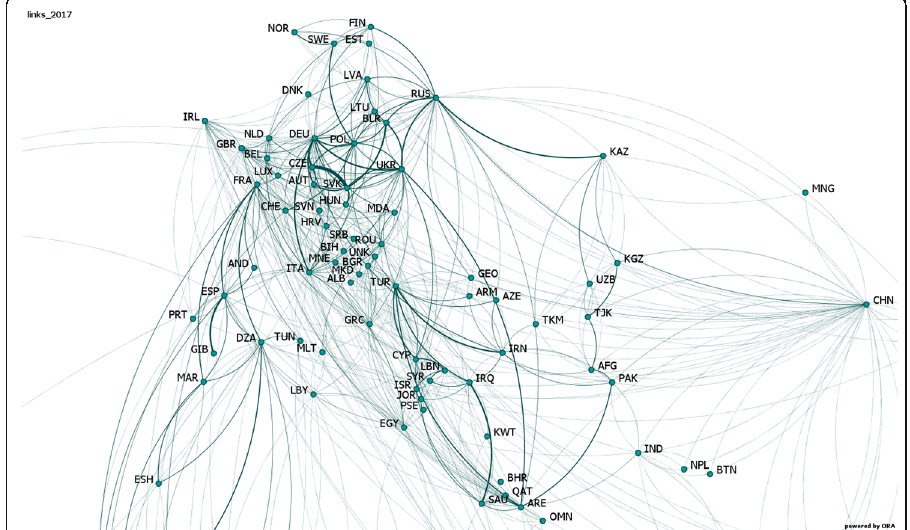
Fig. 7 Aggregate cigarette trafficking network (focus on Europe and neighboring countries), 2017. Note: arrows representing the direction of flows are not depicted to improve visualization. Link width is linearly proportional to the estimated trafficking